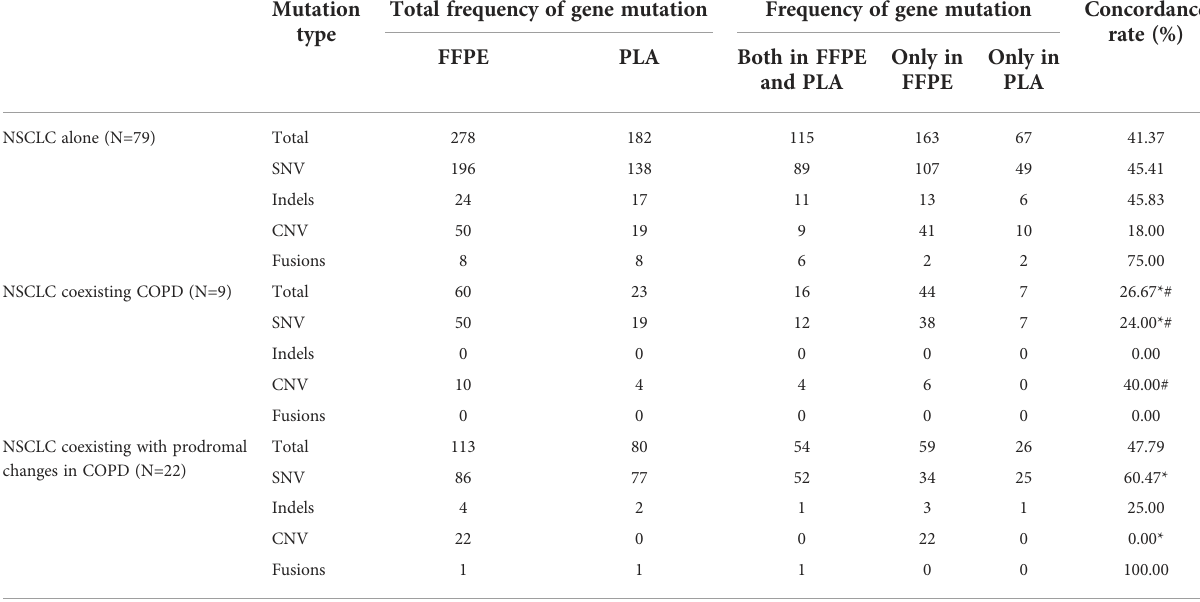
TABLE 4 Comparison of genetic mutation pro fi les for FFPE tDNA and paired PLA ctDNA samples in the NSCLC sub-cohort (N=110).